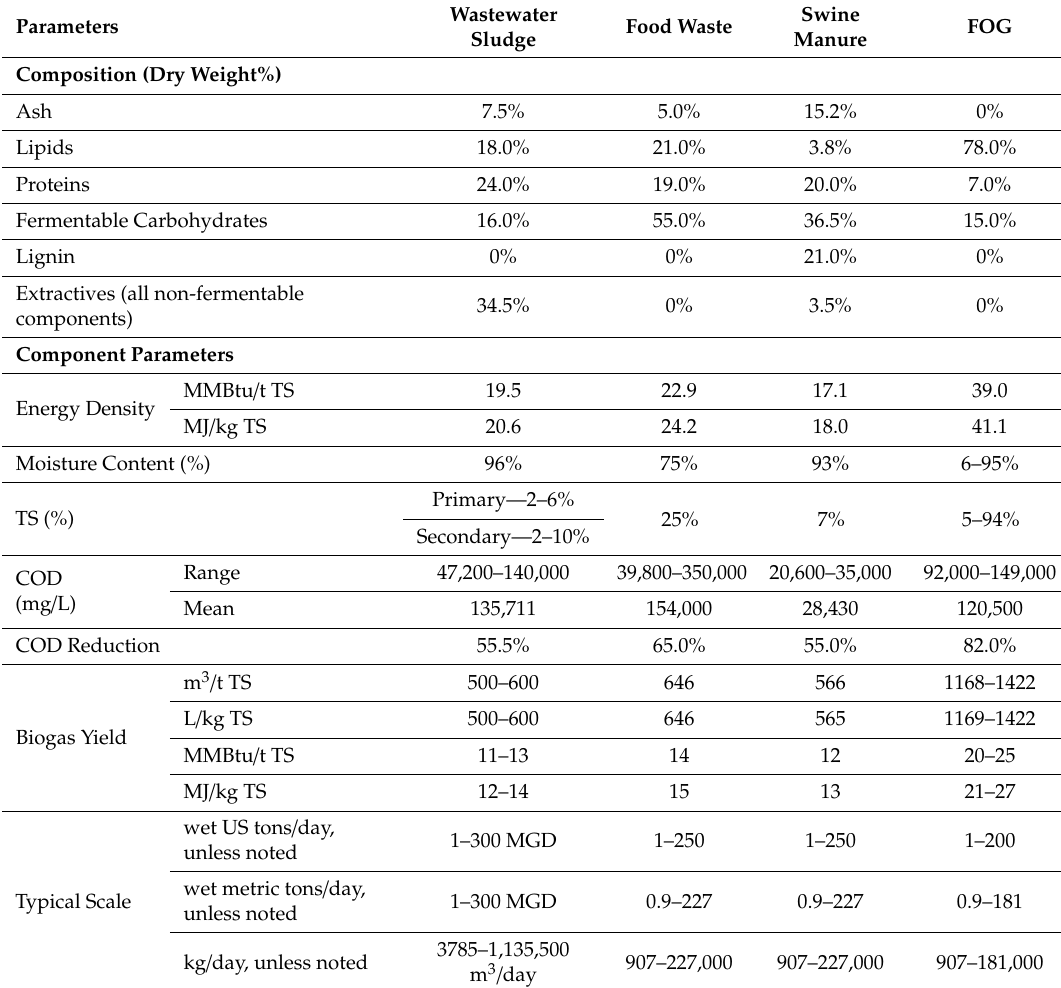
Table 1. Composition of Wet Wastes and Physical Parameters for Biogas Production via Anaerobic